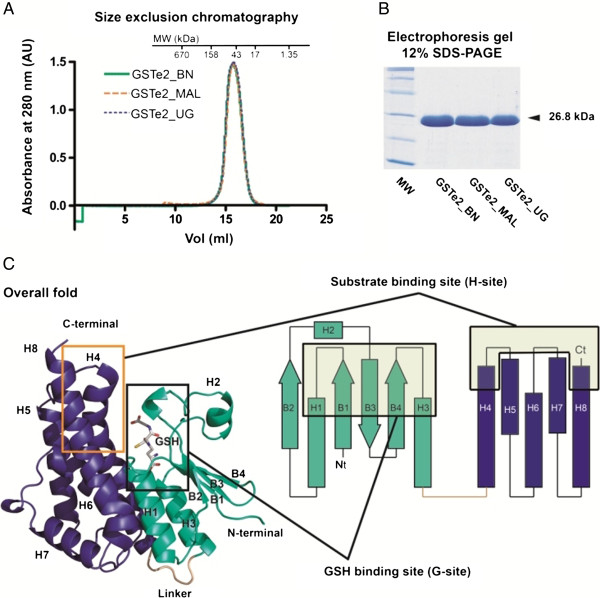
GSTe2 purification and X-ray three-dimensional structure. (A) Size-exclusion chromatogram of GSTe2 alleles from Benin (BN), Uganda (UG) and Malawi (MAL) alleles. The lines show the absorbance recorded at 280 nm. Molecular-weight markers (Bio-Rad, Hercules, CA, US) are indicated in kilodaltons. (B) SDS-PAGE gel of the three purified GSTe2 alleles (26.8 kDa). (C) Topology of GSTe2 showing the C- and N-terminals, the GSH binding pocket (G-site) and the substrate-binding pocket (H-site). AU, arbitrary units; BN, Benin; GSH, glutathione; MAL, Malawi; MW, molecular weight; UG, Uganda; vol, volume.